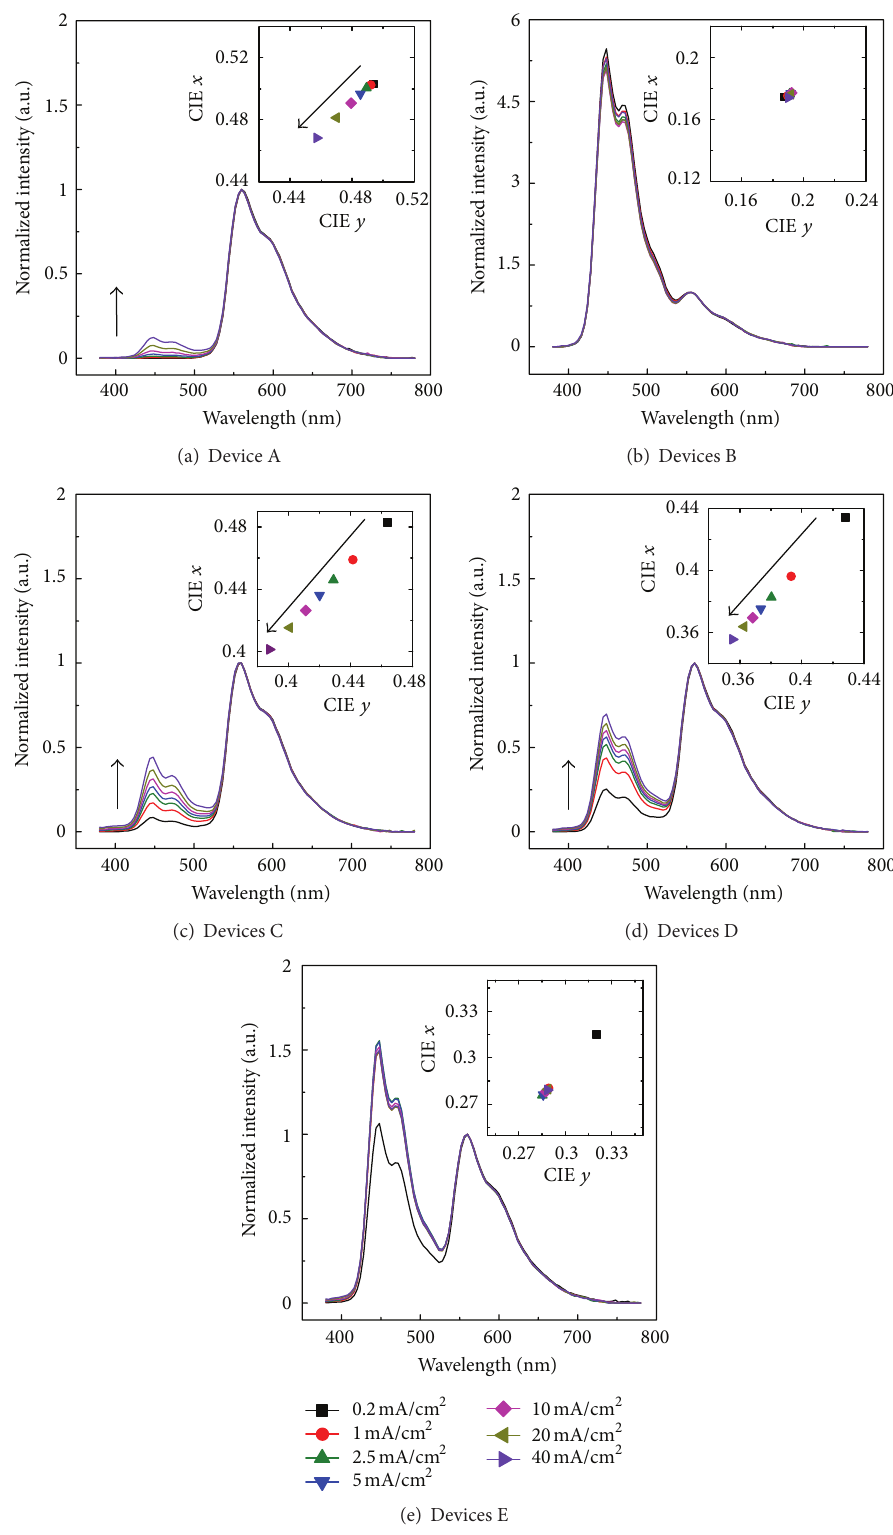
Figure 5: (a)–(e) Normalized EL spectra of HWOLEDs with different current density. Each inset shows the corresponding CIE coordinates with the same coordinate scale of Δ CIE (0.1, 0.1). The arrows indicate the EL spectral and CIE color coordinates varying with increasing current density from 0.2 to 40mA/cm 2